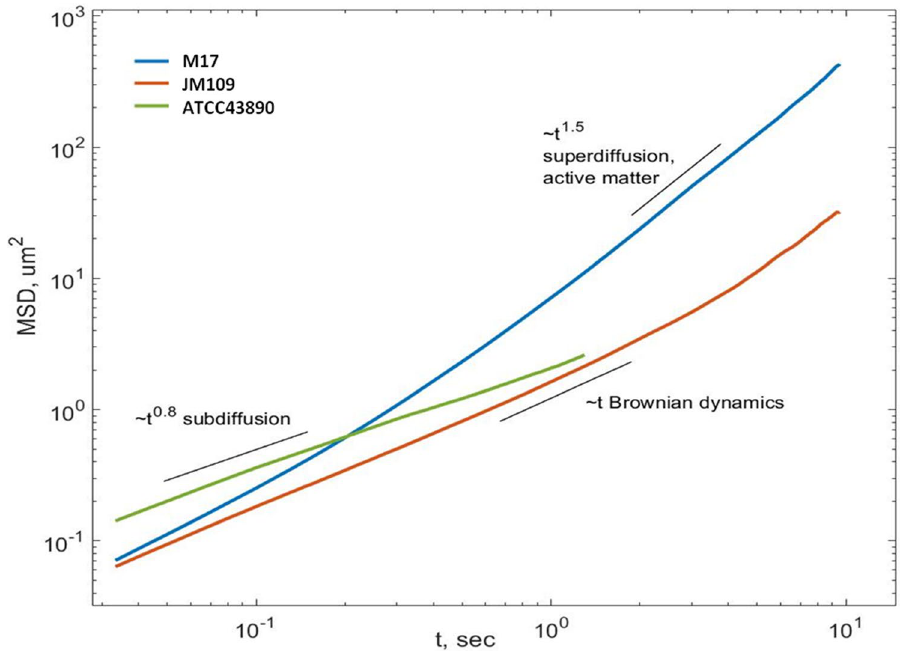
Figure 5. Log–log time dependence of mean square displacement (MSD) for various strains of E . coli